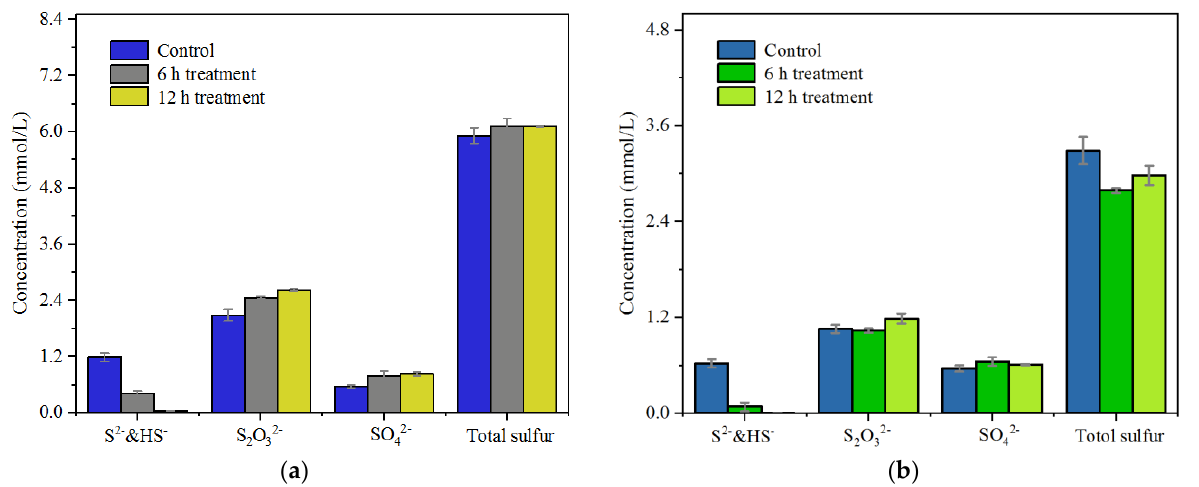
Figure 6. Remediation of S 2− in KWE by N,Fe-CDs, ( a ) Original KWE, pH 12.7 and ( b ) Neutralized KWE, pH 7.